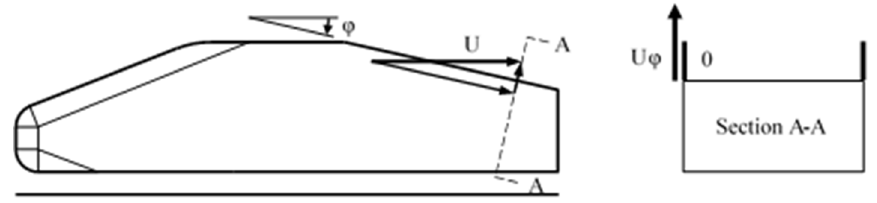
Figure A1. Slant edge flow schematic.